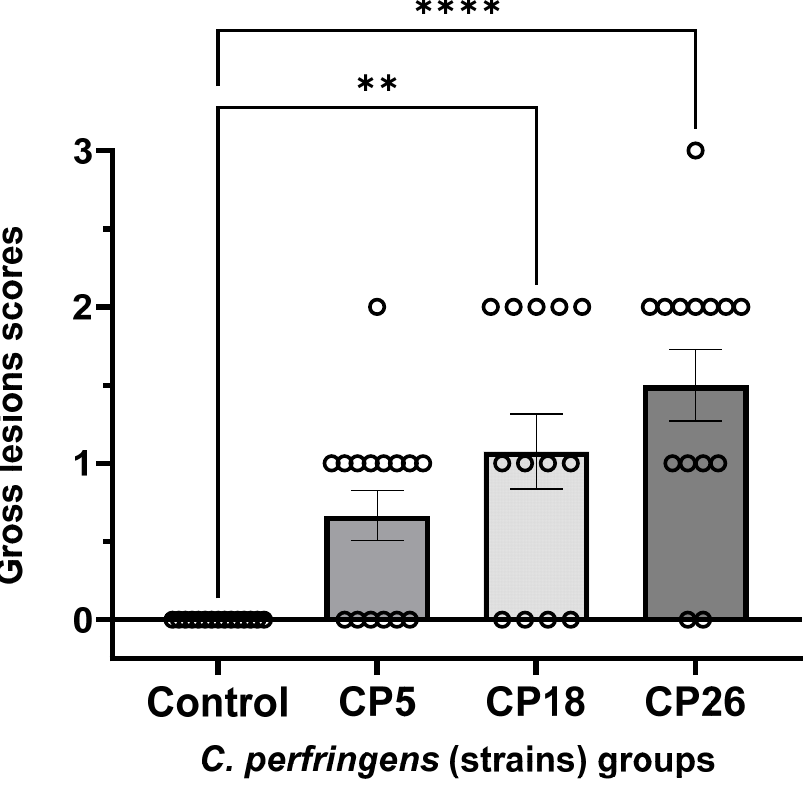
Figure 2. Gross pathology lesion scores in the small intestines of chickens intracloacally infected with C. perfringens strains . One-day-old commercial broiler chickens were fed an antibiotic-free diet and challenged with one of three different C. perfringens strains along with the uninfected control via intracloacal inoculation on day 18 of age, administered twice daily for 4 consecutive days, followed by necropsy on the 22nd day of age. The gross lesions in the small intestine (duodenum to ileum) were scored. Individual animal scores corresponding to each of the groups along with the mean lesion scores are shown. Statistical significance between the treatment groups is indicated above the standard error of mean bars. Control—uninfected; CP— C. perfringens strain. Asterisks above the standard error of mean bars between groups indicate the differences were statistically significant at p < 0.01 (**) or p < 0.0001 (****).